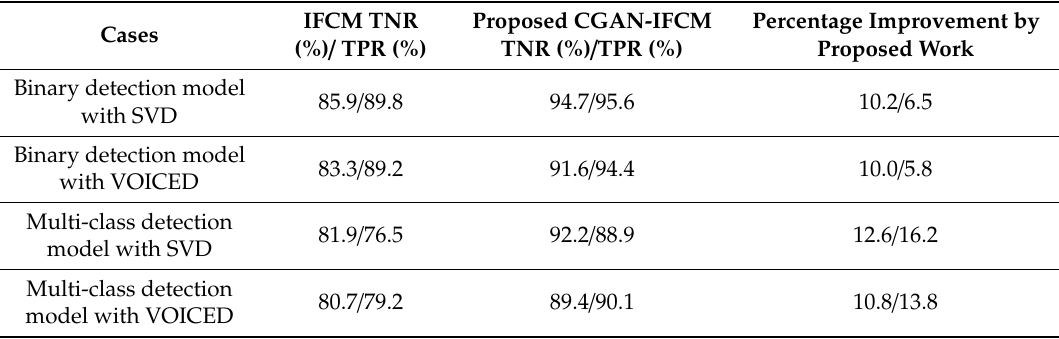
Table 6. Performance comparison between CGAN-IFCM and IFCM.